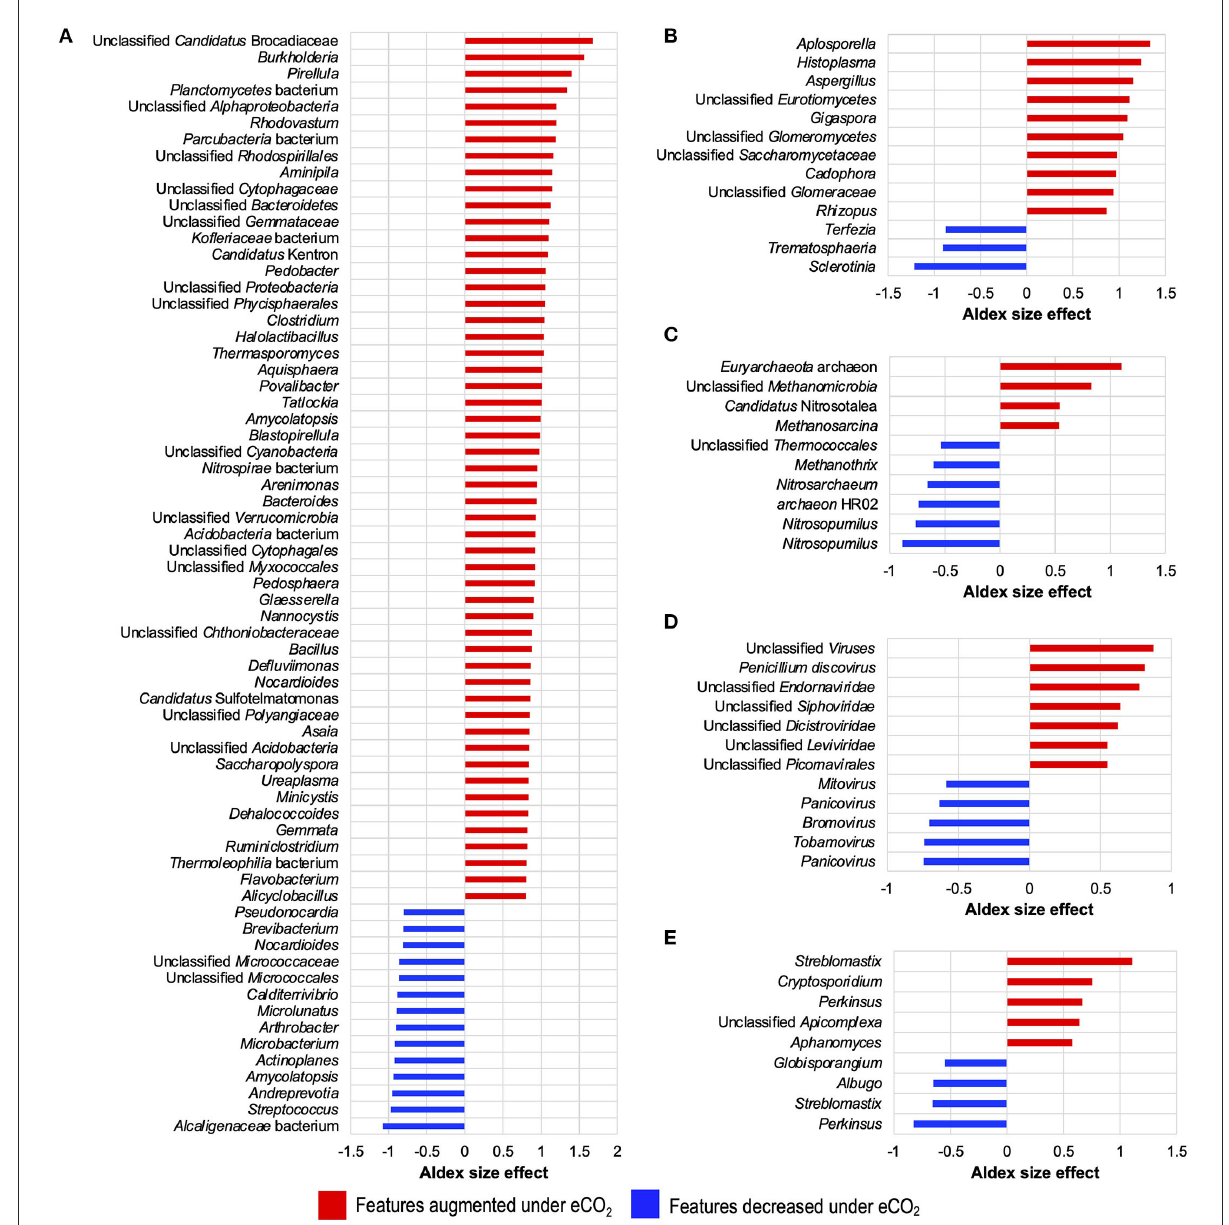
FIGURE2 Differential abundance of core microbial taxa from the Gi-FACE metatranscriptome of (A) bacteria, (B) fungi, (C) archaea, (D) virus, and (E) protist. ALDEx2 results of features with an ALDEx2 effect size > 0.5 using centered log ratio (clr) transformation and the geometric mean abundance of all